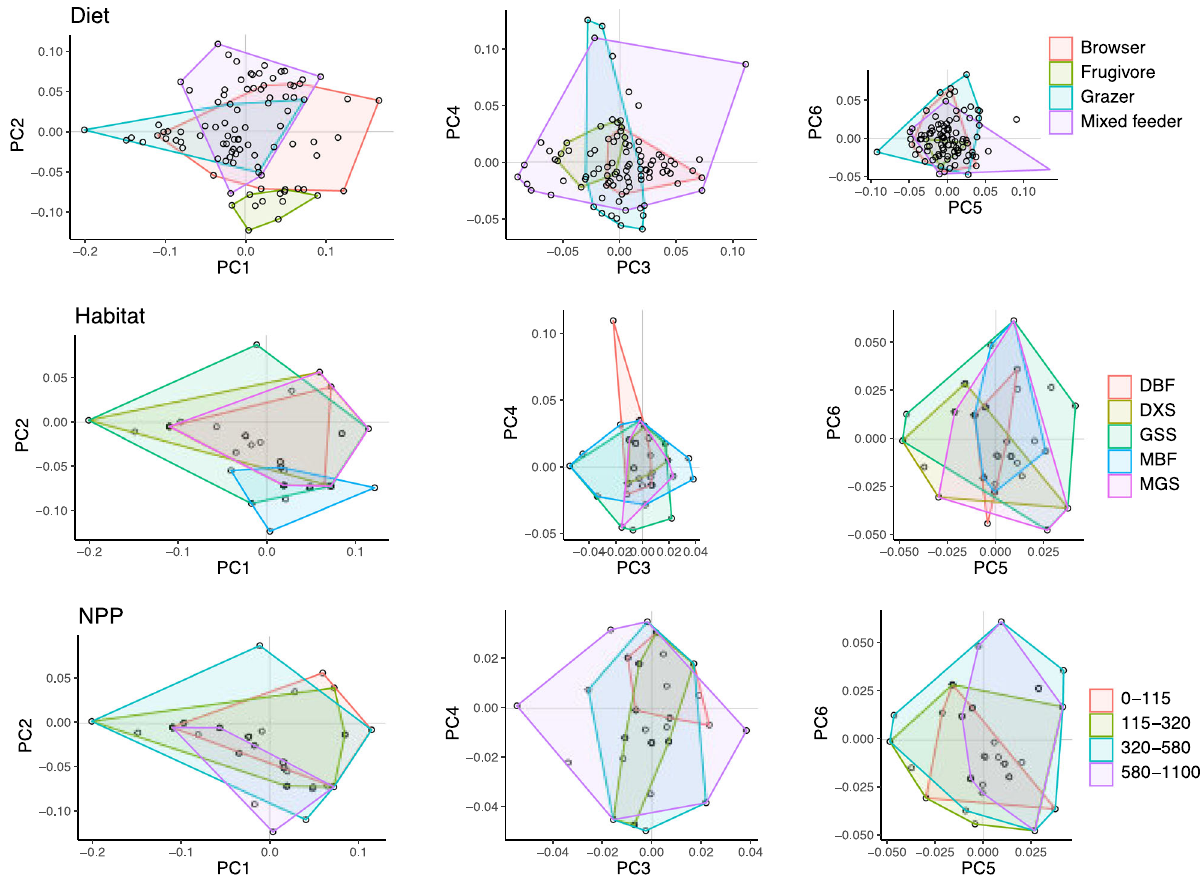
Fig. 6 Distribution of diet, habitat, and net primary productivity (NPP) categories in shape space. Habitat and NPP use just 20% most commonly occurring species in each category (see also Supplementary Fig. 8). Some discrimination can be seen along PC1 and PC2, but otherwise all categories exhibit high morphological overlap and differences are not signi fi cant. Habitat abbreviations: DBF tropical and subtropical dry broadleaf forests, DXS tropical and subtropical deserts and xeric shrublands, GSS grasslands, savannas, and shrublands, MBF moist broadleaf forests, MGS montane grasslands and shrublands. NPP is in trillions of kgs of carbon per 1 degree